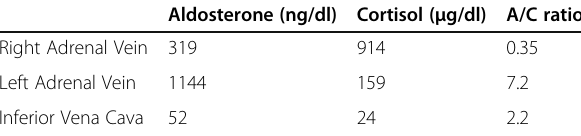
Table 7 Results from AVS in a 31y/o female with a history of hypertension and hypokalemia who was found to have PA by ARR (237). CT (not shown) showed normal appearing bilateral adrenal glands. Samples were taken with continuous cosyntropin infusion at 50 μ g/hr. Left sided sampling was done in the common phrenic adrenal trunk. Ratios between the adrenal vein cortisol and IVC cortisol, the SI, are used to determine sampling adequacy. In this case SI on the right is 38.1 (914/24) and 6.6 (159/24) on the left, the latter number lower because of dilution from the inferior phrenic vein. The lateralization index is 20 (7.2/.35) with a CSI of 0.16 (.35/2.2). The patient underwent left adrenalectomy with hypertension